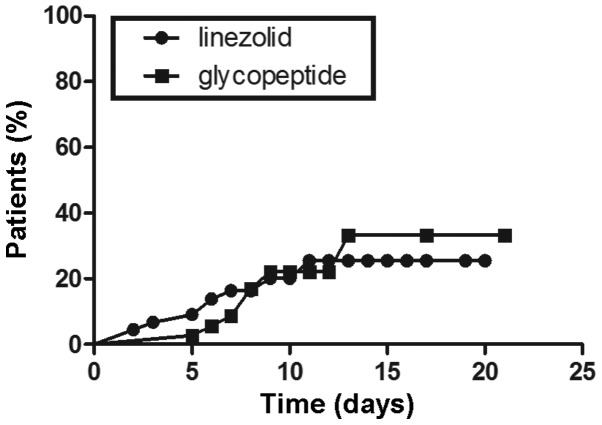
Kaplan-Meier plot of the probability of the number of platelets being <100×109/l in patients aged <65 years. Log rank test P=0.884.